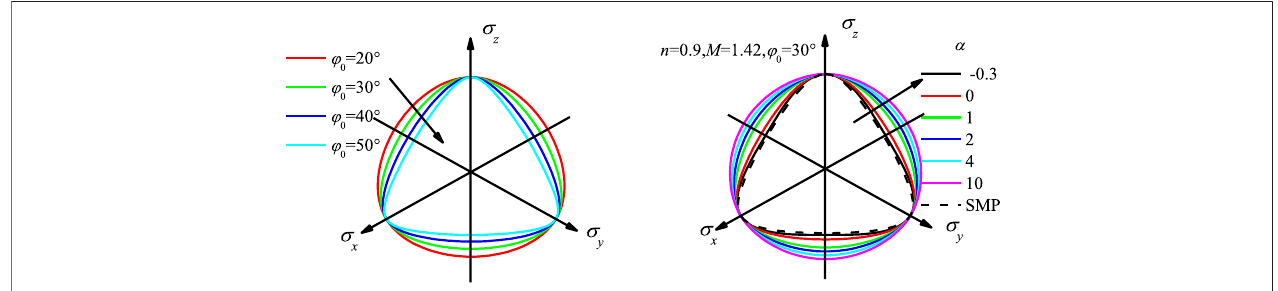
FIGURE 1 | Criterion variation with different parameters on the deviatoric plane.